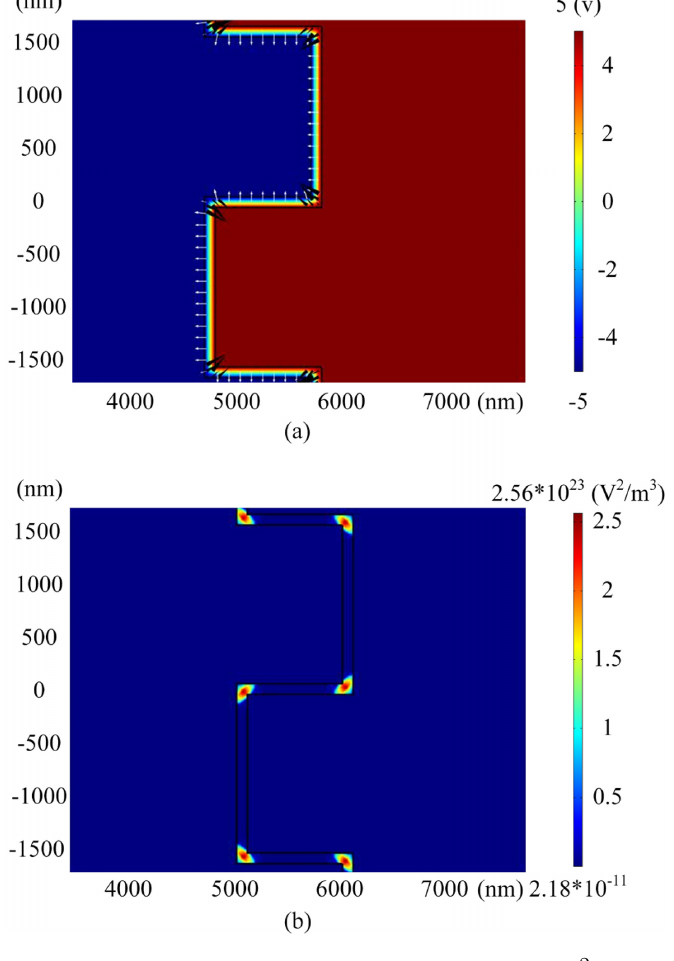
E ∇ distribution distribution generated rms rms E ∇ distribution rms E ∇ distribution rms rms E ∇ rms